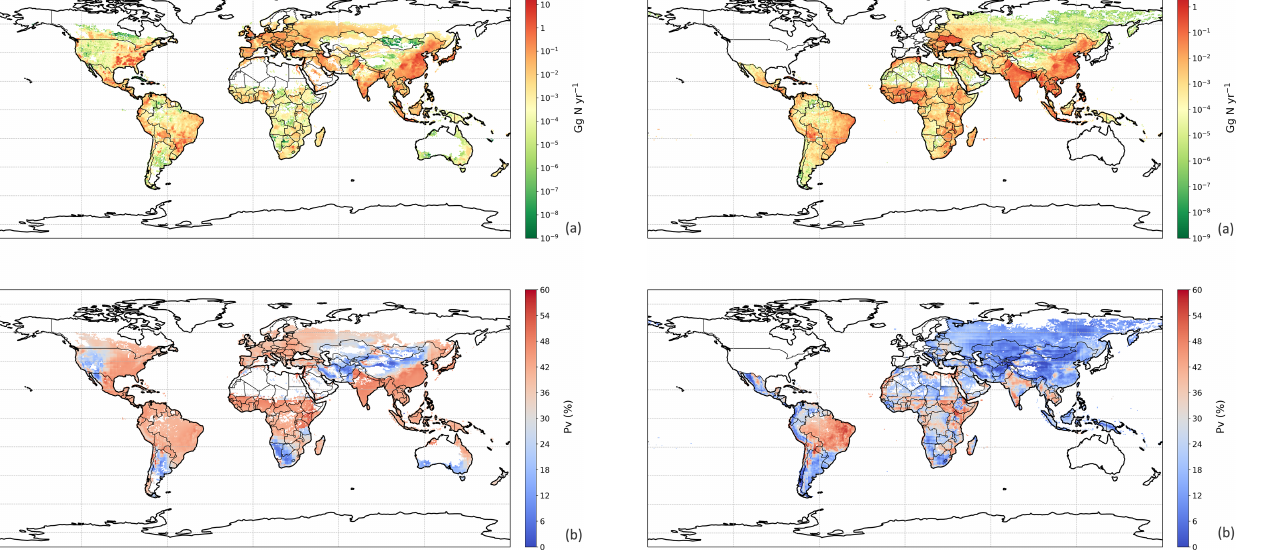
Figure 11. Same as Fig. 9 but for backyard chicken in